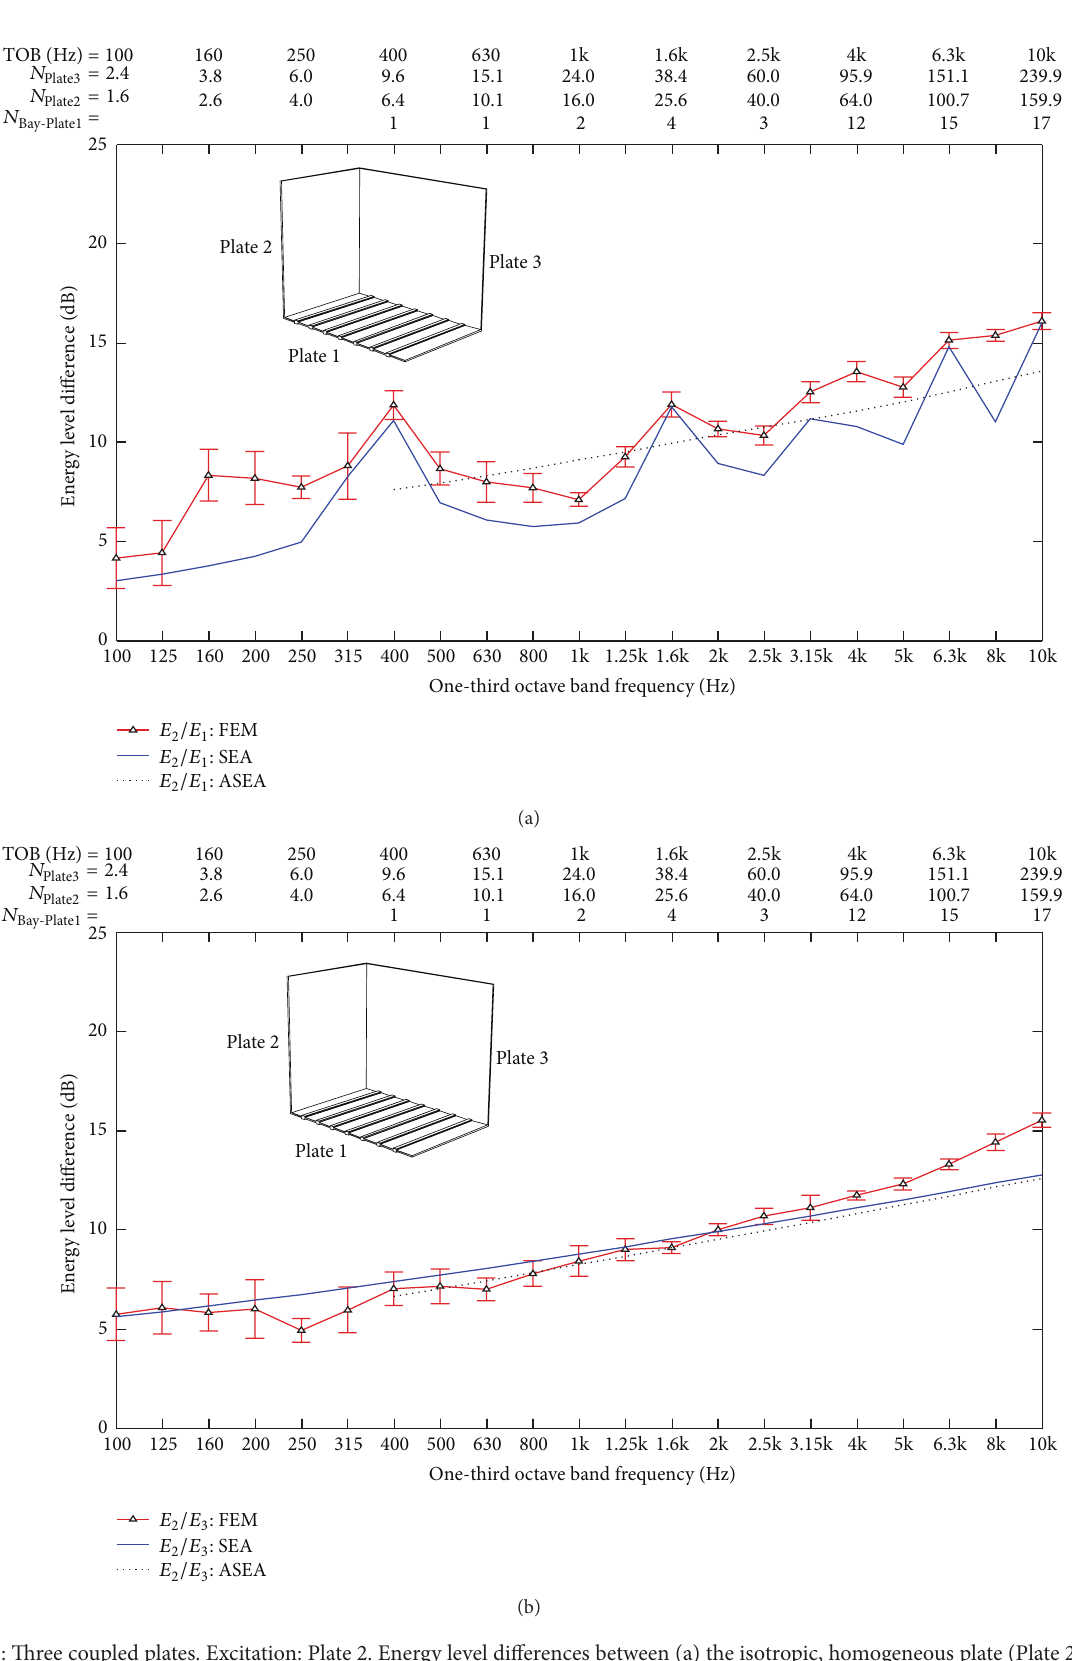
Figure 16: Three coupled plates. Excitation: Plate 2. Energy level differences between (a) the isotropic, homogeneous plate (Plate 2) and the periodic ribbed plate (Plate 1) and (b) the isotropic, homogeneous plate (Plate 2) and the isotropic, homogeneous plate (Plate